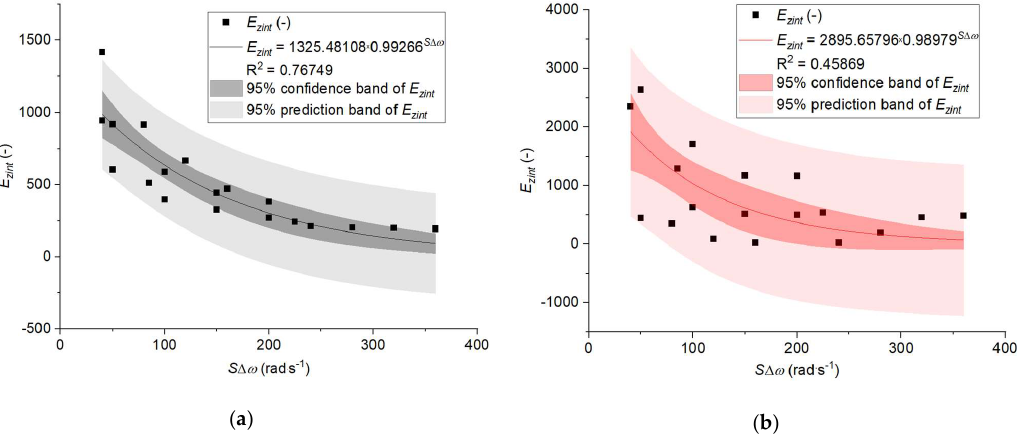
Figure 14. The integrated energy consumption as a function of the total speed increase with the indication of the confidence interval and predicted values for: ( a ) rice grain comminution and ( b ) corn indication of the confidence interval and predicted values for: a) rice grain comminution and b) corn grain comminution. grain Table 10. Results of significance tests for the coefficients of the integrated energy consumption regression model.